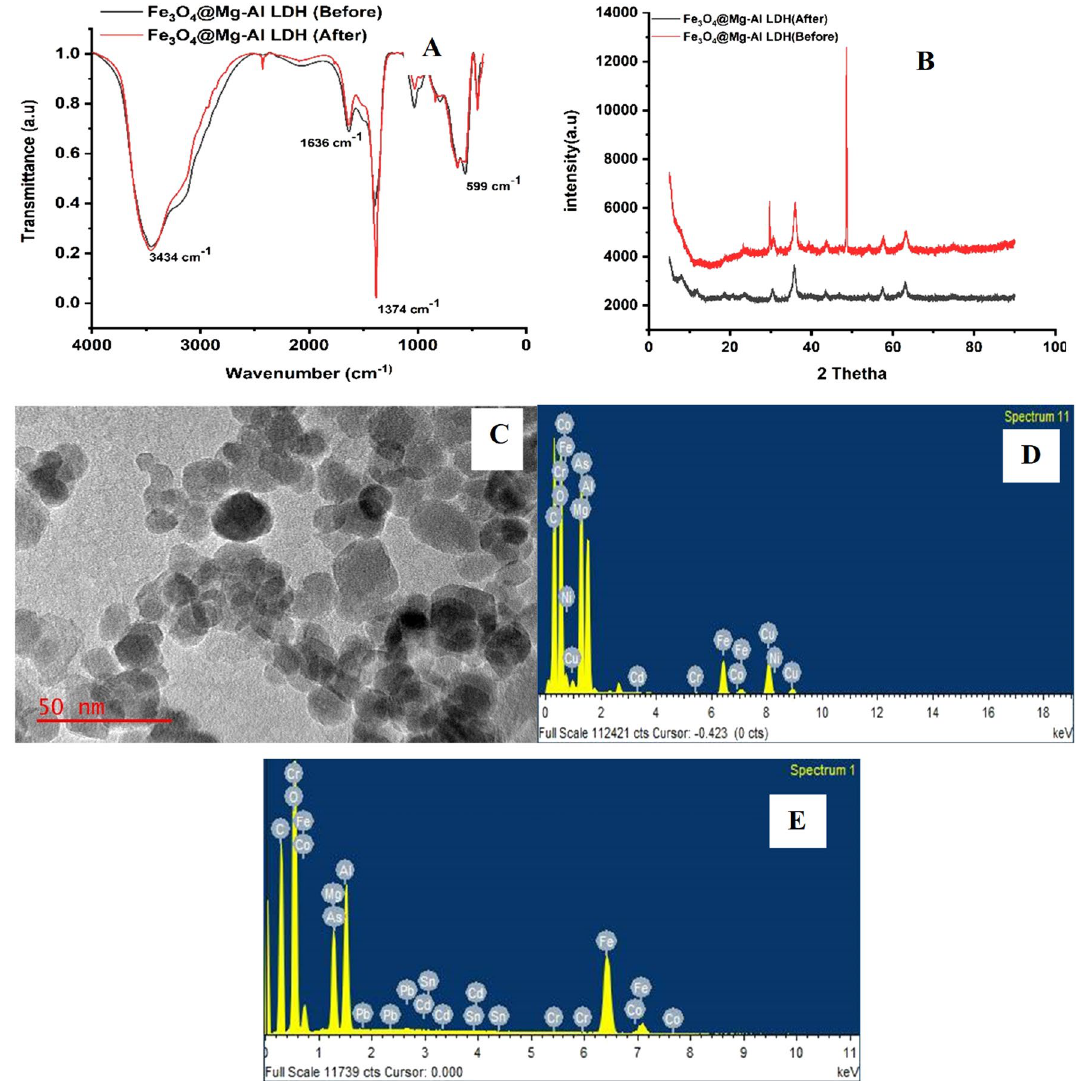
Figure 9. ( a ) FTIR spectra ( b ) XRD ( c ) TEM image and ( d , e ) EDS